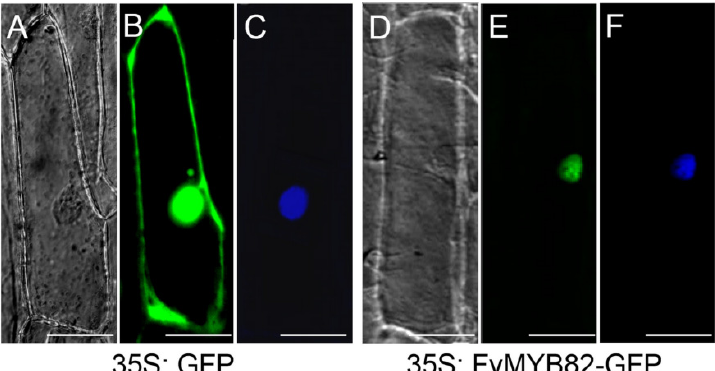
Figure 3. Subcellular localization of FvMYB82 in onion leaf epidermal cells. The 35S:GFP and 35S:FvMYB82 plasmids were transformed into the cells by particle bombardment. ( A , D ) Bright-field images, ( B , E ) GFP fluorescence, ( C , F ) cells stained with DAPI. Bar = 50 μ m.